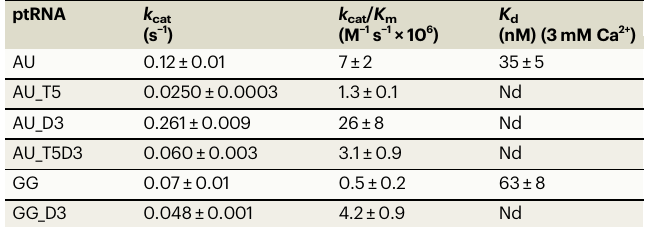
Table 1 | Multiple turnover kinetics, binding af fi nity, and dis- sociation kinetics of ptRNA_AU and ptRNA_GG